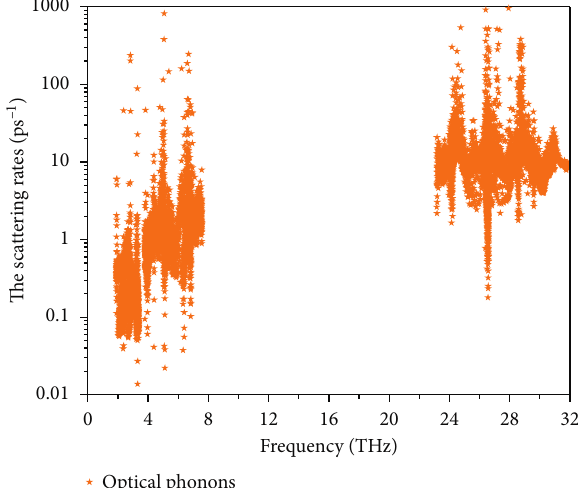
Figure 7: Lattice thermal conductivity κ of monolayer CaHBr at ı different temperatures ranging from 30K to 1200K. Black squares, our results from RTA; red circles, our results from iterative solution of BTE with scalebroad �